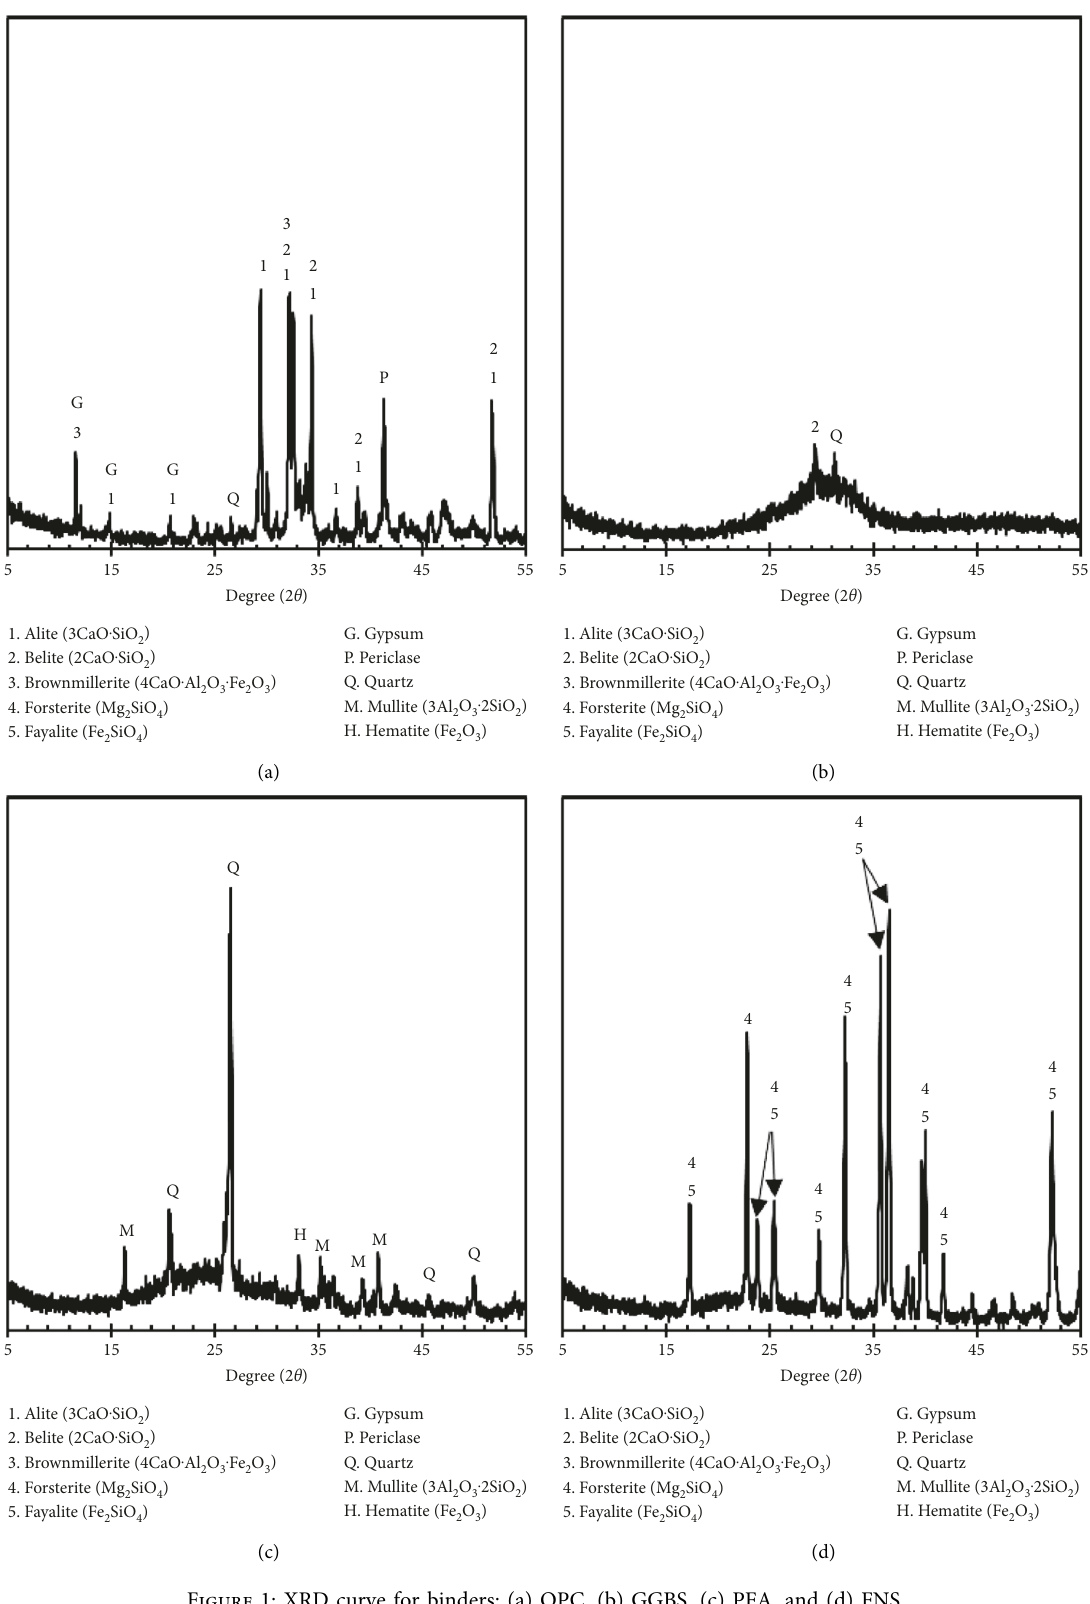
Figure 1: XRD curve for binders: (a) OPC, (b) GGBS, (c) PFA, and (d)